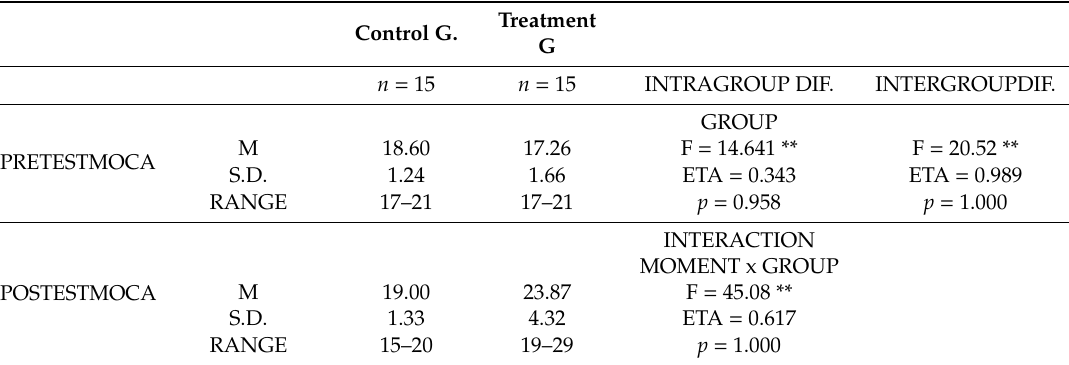
M 19.00 23.87 F = 45.08 ** POSTESTMOCA 15–20